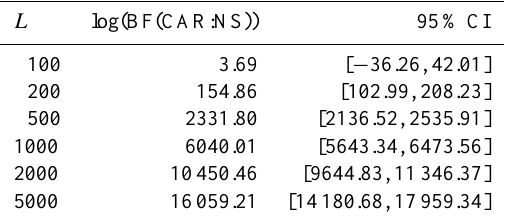
Table 1. Posterior means and 95% credible intervals for log(BF(CAR:NS)) from the analyses of 1000 synthetic data